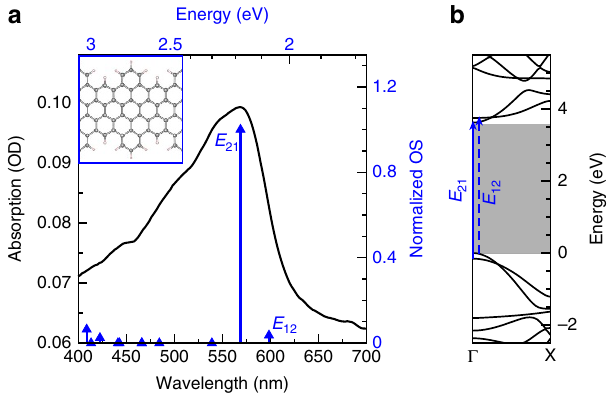
Figure 1 | Linear absorption and excitons in GNRs. ( a ) Linear absorption spectrum of the 4CNR sample in THF solution (black curve). A ball-and- stick model of the GNR without alkyl chains at the edges is shown in the inset. The experimental spectrum is compared with the result of GW -BS calculations, with excitonic transitions indicated by blue arrows. ( b ) GW quasi-particle band structure. The lines indicate the transitions that are mainly contributing to the first and second exciton. The 1.5eV difference between the GW gap ( b ; grey area) and the excitonic transition reported in a defines the exciton binding energy in